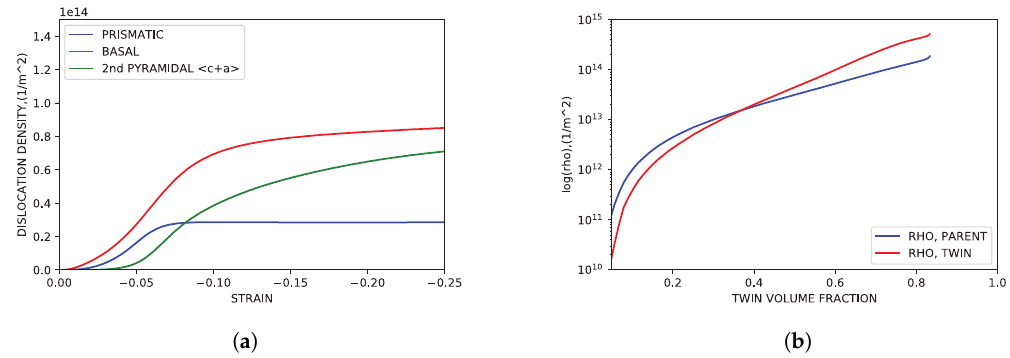
Figure 11. Simulated dislocation density evolution. ( a ) Modal dislocation density vs. strain. ( b ) Dislocation density for parent and primary twin volume fractions vs. primary twin volume fraction.